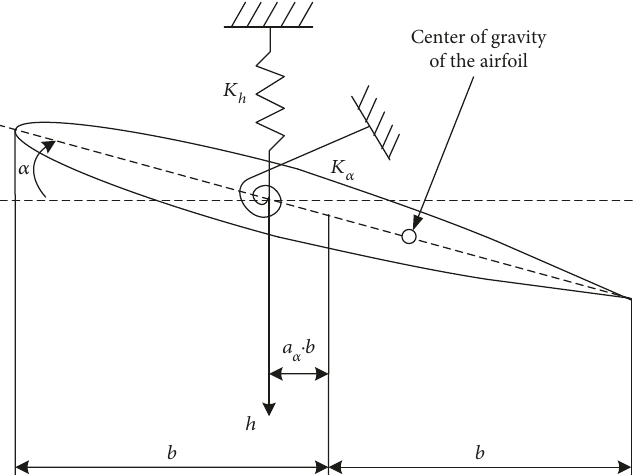
Figure 2: An airfoil of two degrees of freedom.